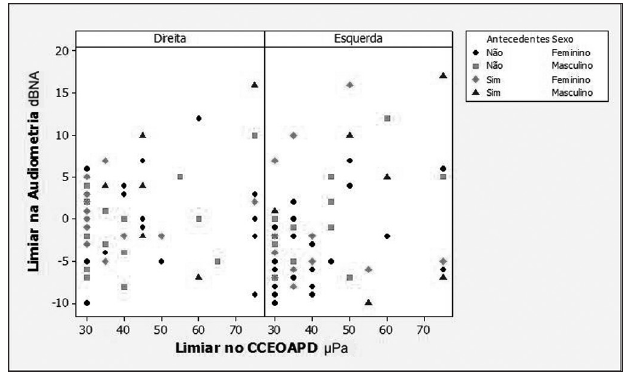
Figura 1. Diagrama de dispersão dos limiares audiométricos e dos limiares das curvas de crescimento das EOA-PD, considerando as variáveis: orelha, antecedentes de otite média e sexo - 2000 Hz.